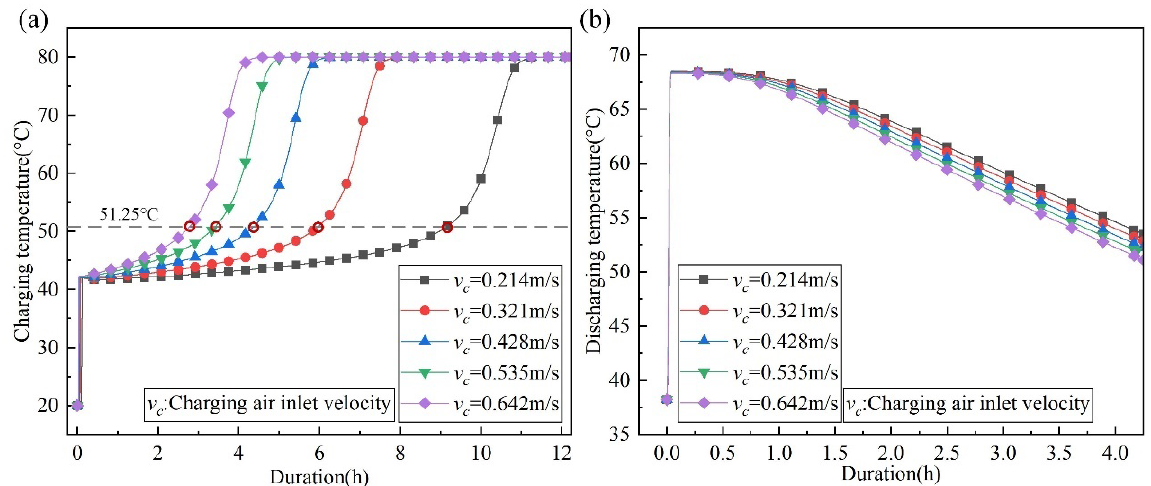
Figure 9. ( a ) Temperature at the charging air outlet and ( b ) temperature at discharging air outlet varies with time at different air inlet velocities of charging.